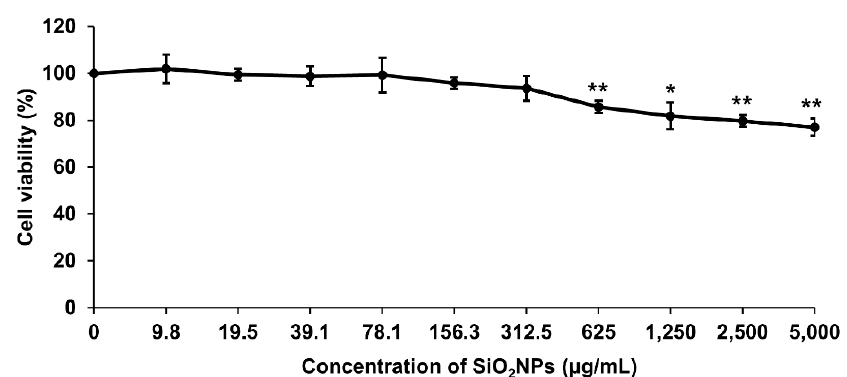
Figure 4. Effects of SiO 2 NPs on cell viability in WB-F344 cells. Data expressed as means ± SD (* p < 0.05 and ** p < 0.01).